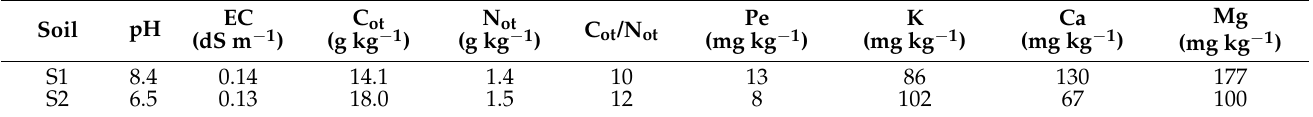
Table 1. Characteristics of the different